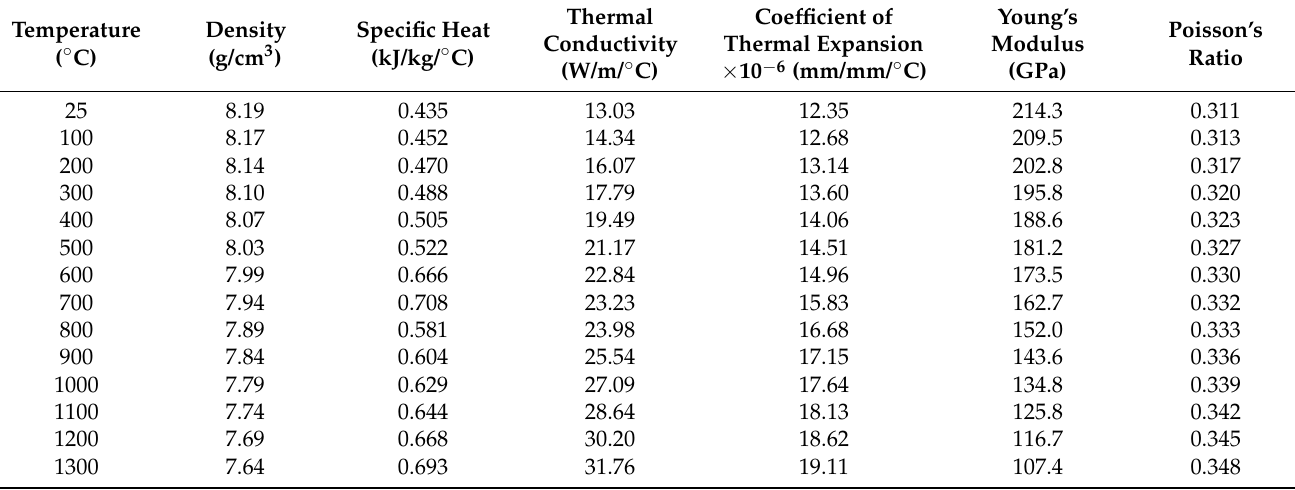
Table 14. Thermo-physical properties data of